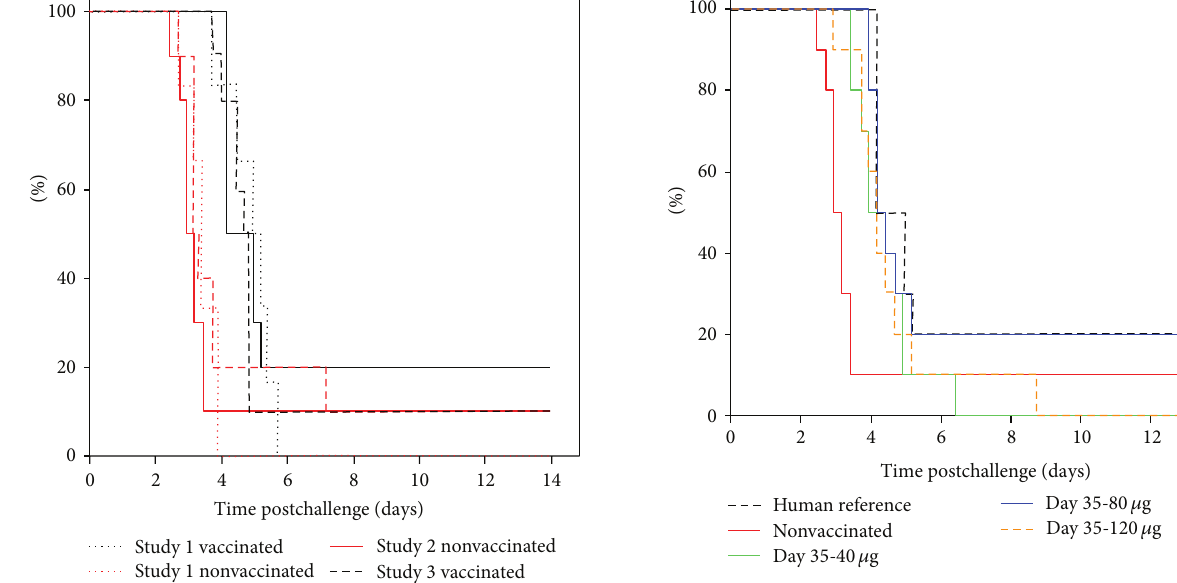
Figure 3: Combined survival plots of BALB/c mice following pas- sive transfer of human serum from vaccines 35 days after receiving different doses of vaccine. Study (2), 𝑛 = 10 per group. Mice were administered 250 𝜇 L human serum into the peritoneal cavity, 3 hours before being exposed to more than 10 LD 50 aerosolised Y. pestis using a modified contained Henderson apparatus. The median time to death (MTD) was calculated using a Kaplan-Meier survival plot.